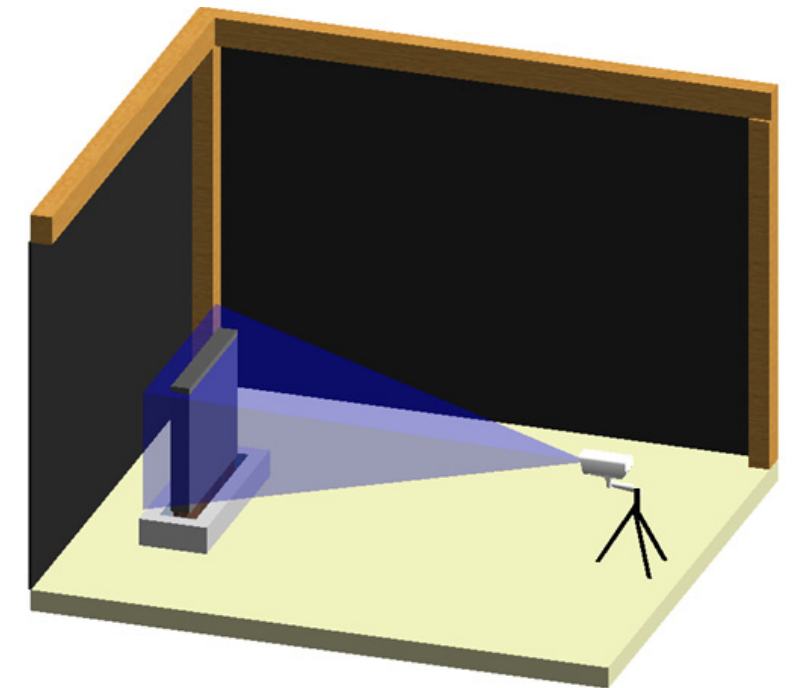
Figure 2. Schematic representation of the test layout. Table 1. Environmental conditions in the hot and cold chambers.